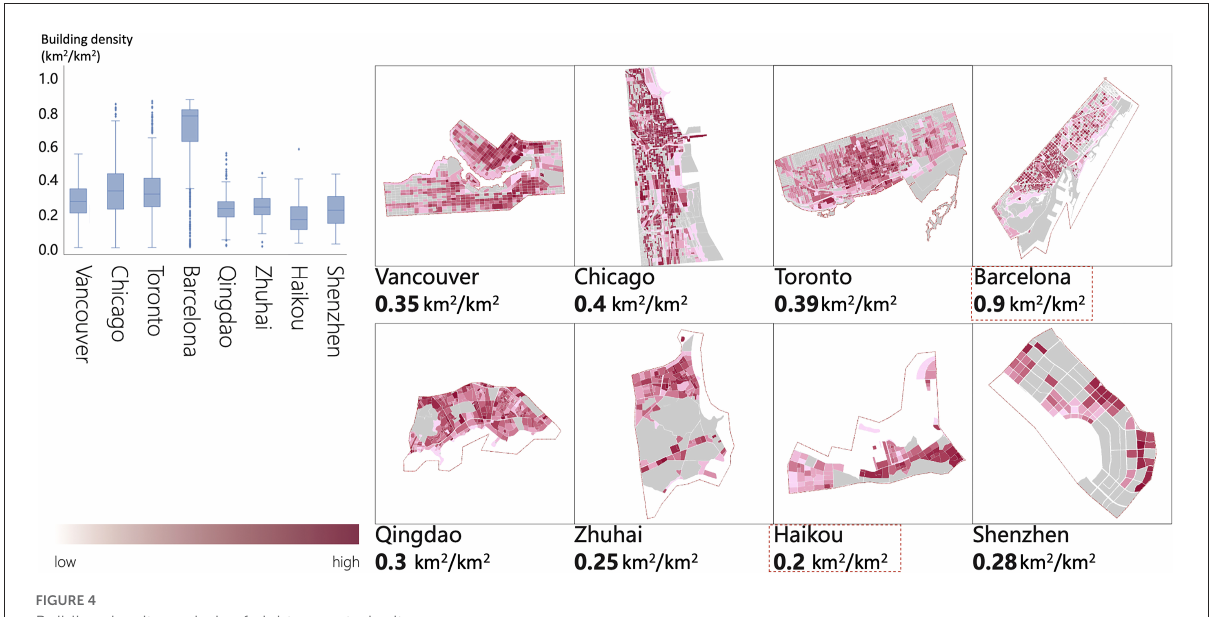
FIGURE4 Building density analysis of eight case study